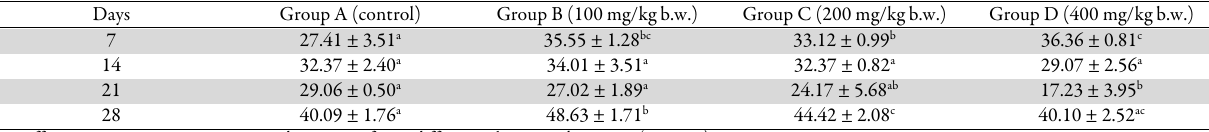
Table 1. Mean serum ALT (IU/l) activities (means ± standard error) of rat groups administered methanol fruit extract of Piper guineense for 28 days Days Group A (control) Group B (100 mg/kg b.w.) Group C (200 mg/kg b.w.)